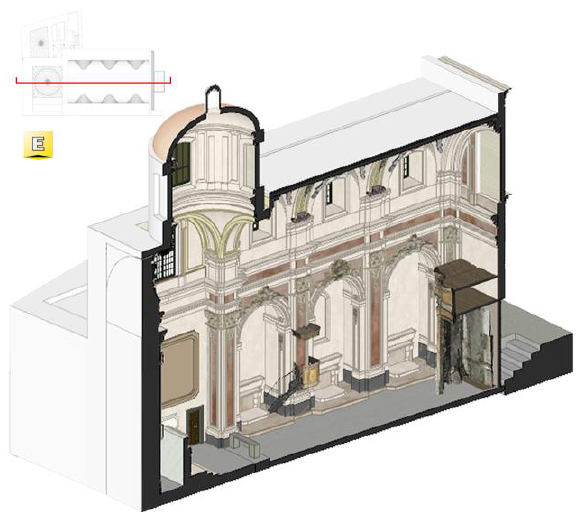
Figure 1 . Church of San Pietro in Vinculis , Naples (Italy): BIM model in